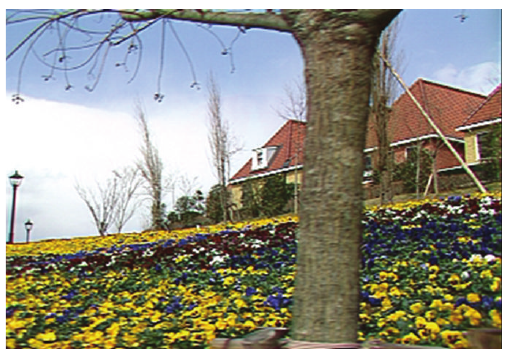
Figure 15: Trend of PSNR ( 𝜌 = 0.006944 ) with respect to frame number for the video